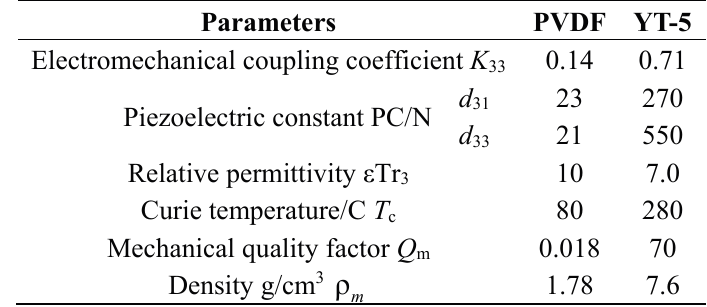
Table 1. Property comparison between PVDF film and YT-5 piezoelectric ceramic.